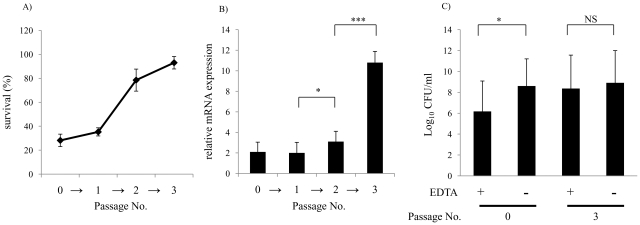
Repeated serum treatment selects for serum resistance, increased vacJ expression, and increased outer membrane stability.(A) Serum sensitive clinical isolate H725 was treated three times in 2.5% NHS and survival quantified after the passage indicated. (B) Following each passage in the bactericidal assay survivors were tested for relative expression of vacJ mRNA by qRT-PCR and (C) survival in the presence of 25 mM EDTA. Values represent two independent experiments in triplicate ± SD.*
P<0.05, ***
P<0.001.